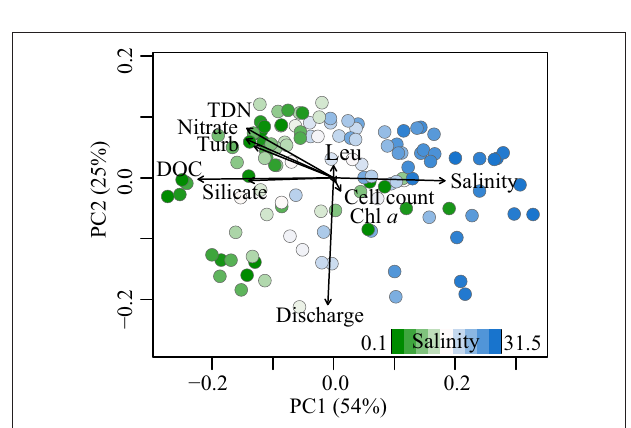
FIGURE 3 | Principal coordinate analysis based on Bray-Curtis dissimilarities of relative peak intensities, color-coded by salinity of each sample. Shown are the first two principal coordinates, accounting for 54 and 25% of the total variability in the dataset. Environmental parameters (black) are fitted to the ordination. Leu, Leucine incorporation; Turb,